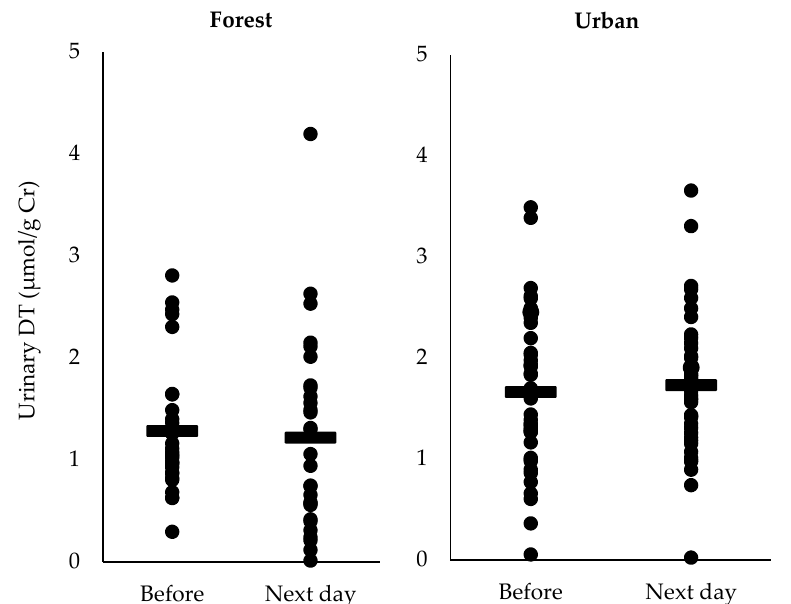
Figure 2. Urinary dityrosine (DT) concentrations pre- and post-forest walk or urban walk. “ — ” denotes the mean value of data.